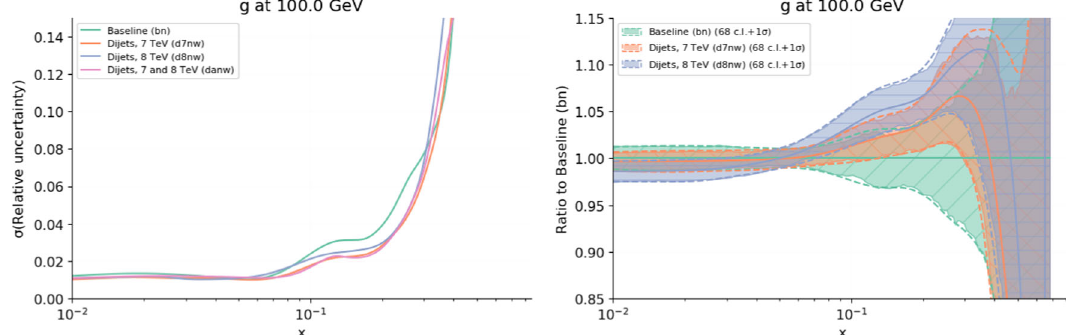
Fig. 14 Same as Fig. 7, but now for dijets